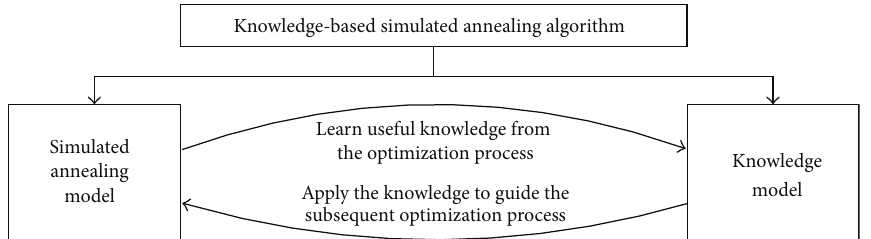
Figure 1: The basic framework of knowledge-based simulated annealing algorithm.